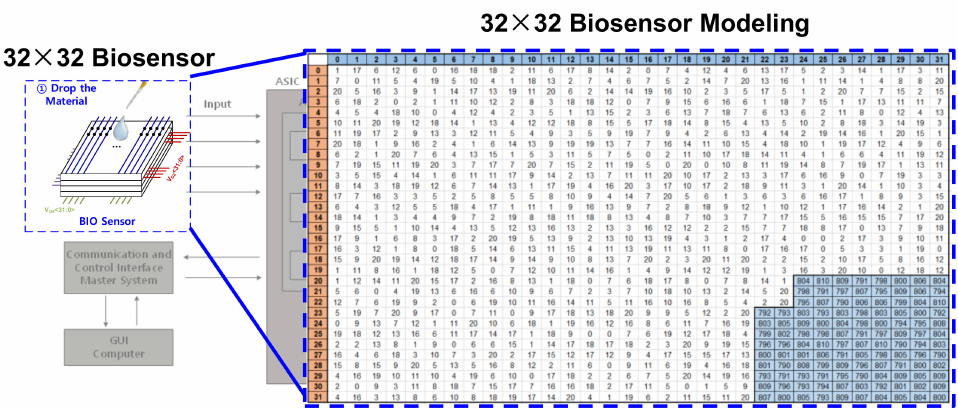
Figure 19. Input feature of B disease.